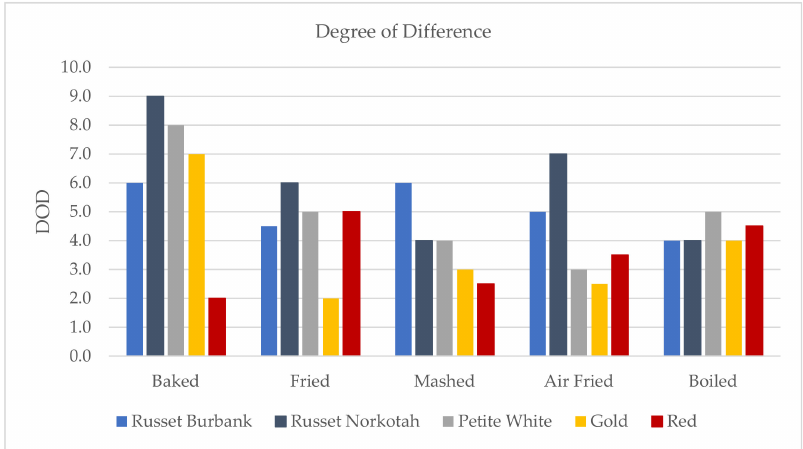
Figure 7. Degree of di ff erence (DOD) from control scores for all varieties and cooking methods. DOD was rated on a 0–15 scale with 0.5